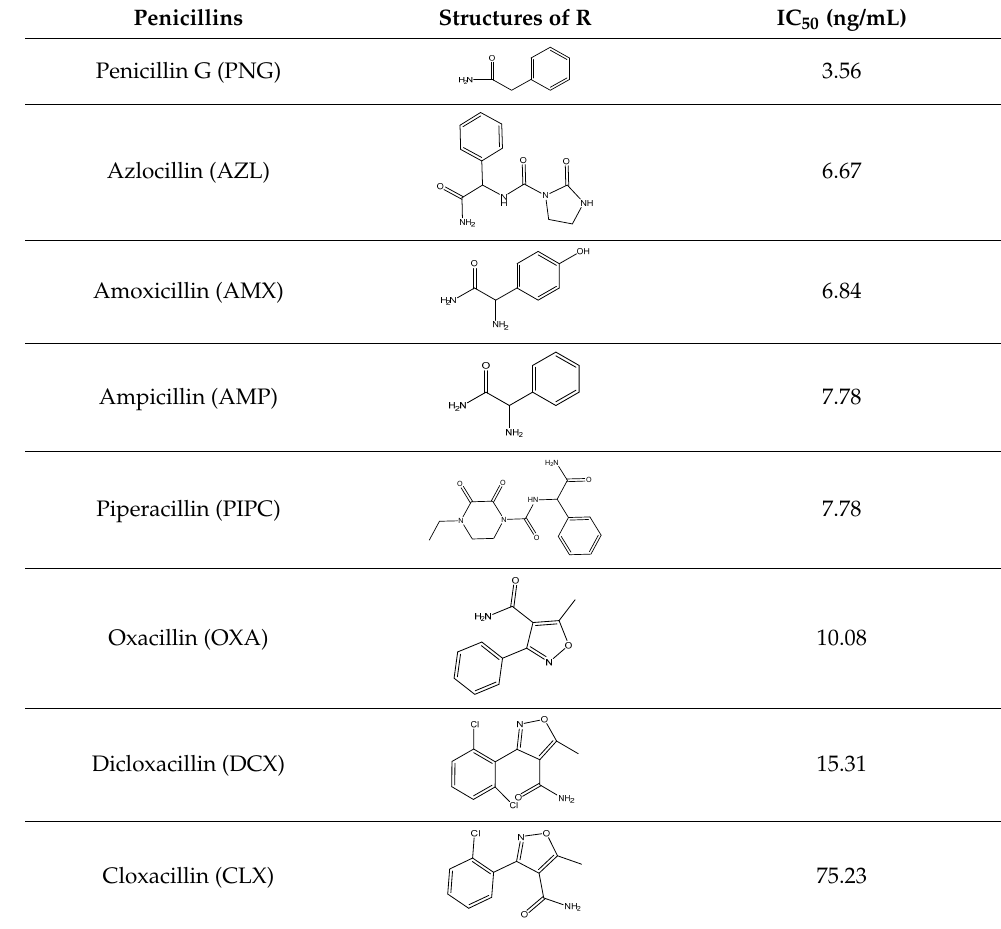
Table 2. The affinity of cephalosporins to PBP2x*.